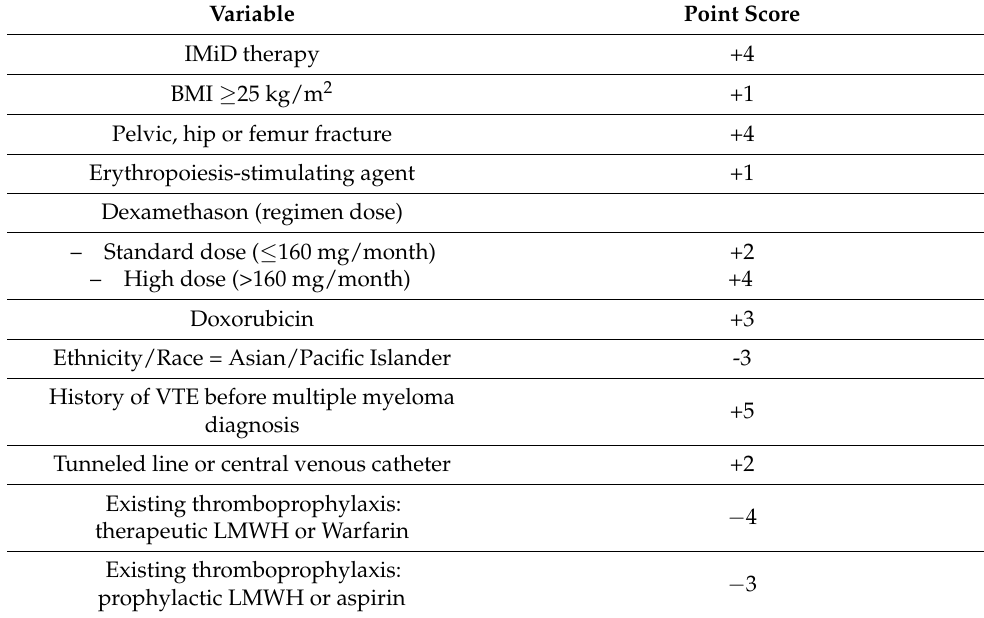
Table 6. IMPEDE-VTE Score, adapted from